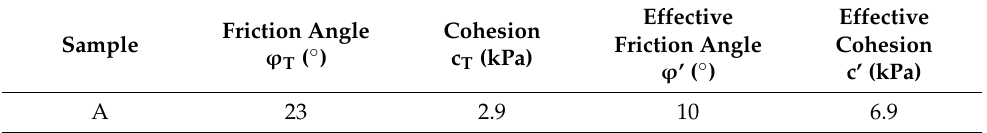
Table 3. Strength parameters of paste